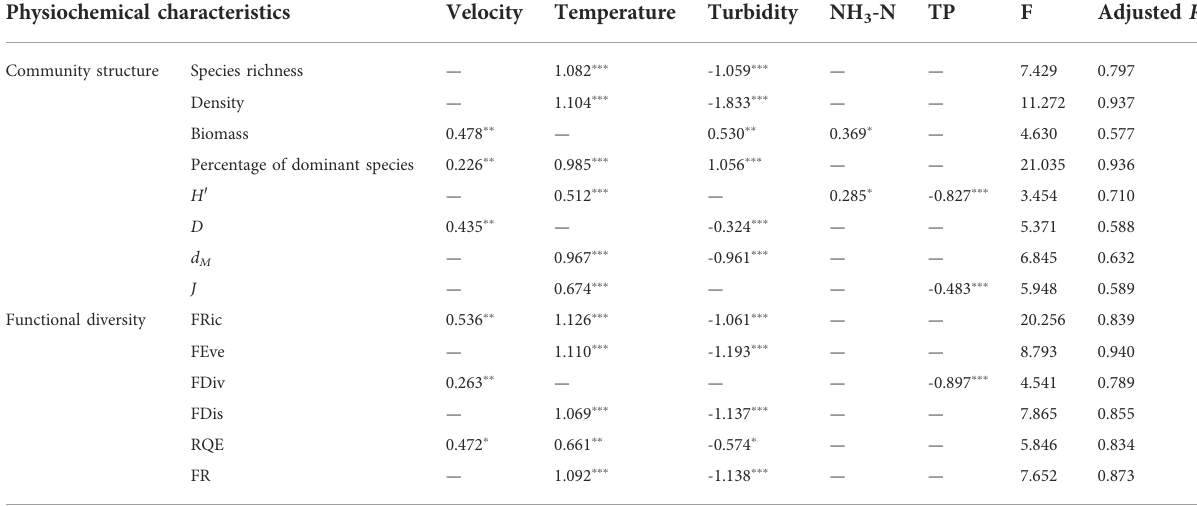
TABLE 2 Multiple linear regression analysis of macroinvertebrate community parameters and environmental factors ( n = 75). Physiochemical